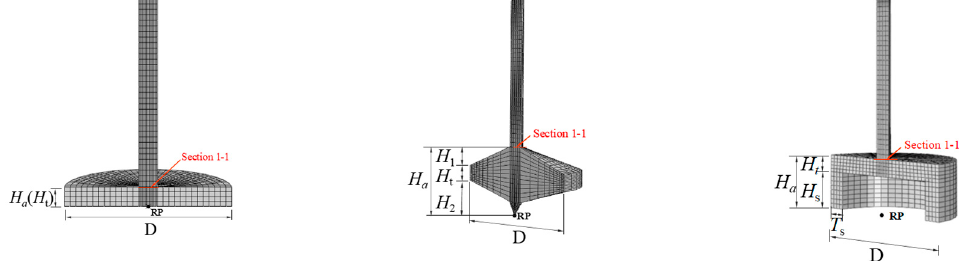
Figure 4. The dimensions of footings: flat base footing, fusiform spudcan footing and skirted footing.